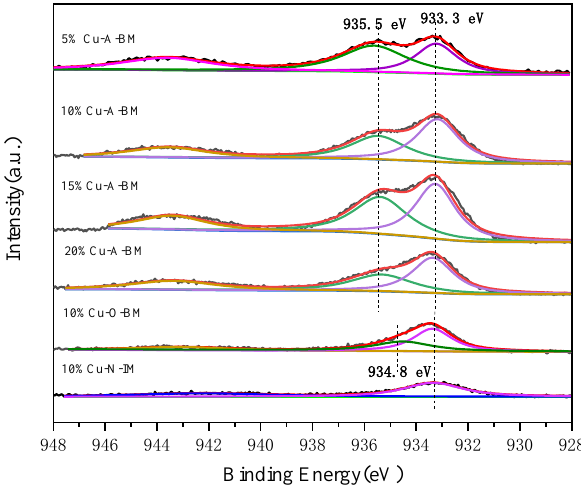
Figure 5. Cu2p spectra of CuO/SiO 2 catalysts. Table 3. Atomic ratio of Cu, CO, CP, and molar ratio of CO/CP over the prepared catalysts.